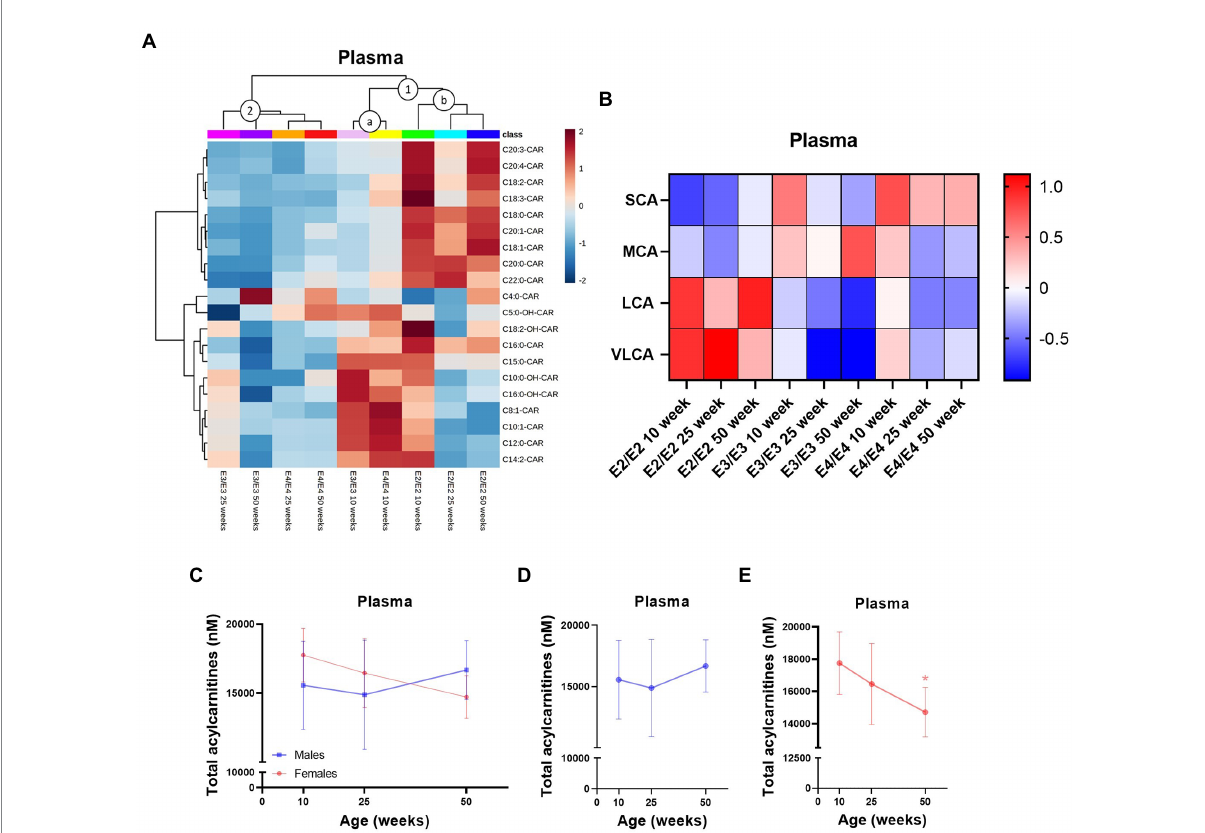
FIGURE 4 Plasma acylcarnitines are affected by APOE , age, and sex. (A) Hierarchical clustering heatmap showing acylcarnitine species with APOE genotypes at different age timepoints in plasma. (B) Z-score heatmap showing acylcarnitine chain length ratios to total acylcarnitines with APOE genotypes at different age timepoints in plasma. (C) Line graphs showing mean plasma total acylcarnitines ± SD in nM in males and females at different age timepoints. (D) Line graphs showing mean plasma total acylcarnitines ± SD in nM in males at different age timepoints. (E) Line graphs showing mean plasma total acylcarnitines ± SD in nM in females at different age timepoints, * comparison with 10 weeks. Statistics: For the clustering heatmap data were normalized and scaled before being analyzed using Ward’s clustering, with the top 20 acylcarnitines selected by ANOVA. Multiple comparisons with B-H correction were performed on the data, * p < 0.05, ** p < 0.01, *** p < 0.001. Numbers per group; 10-week APOE2-TR n = 6, 25-week APOE2-TR n = 5, 50-week APOE2-TR n = 6, 10-week APOE3-TR n = 6, 25-week APOE3- TR n = 5, 50-week APOE3-TR n = 6, 10-week APOE4-TR n = 6, 25-week APOE4-TR n = 6, 50-week APOE4-TR n = 4, 10-week (males) n = 9, 25- week (males) n = 8, 50-week (males) n = 9, 10-week (females) n = 9, 25-week (females) n = 8, 50-week (females) n = 7. Cx:y-CAR,